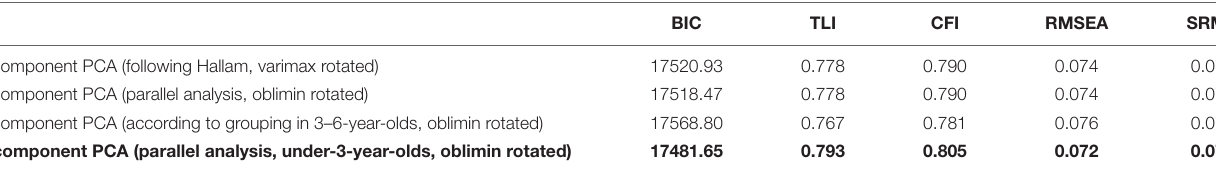
TABLE 2 | Fit indices of computed models.